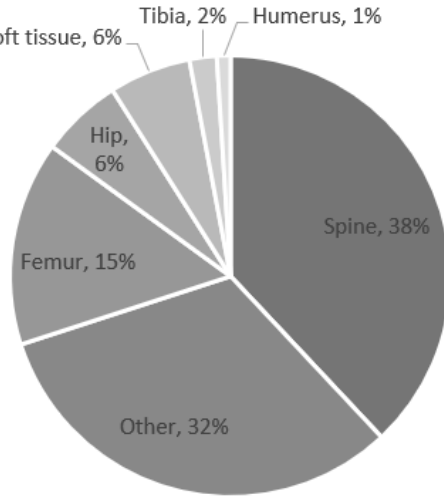
Figure 1. Percentage of postoperative urinary retention by location.